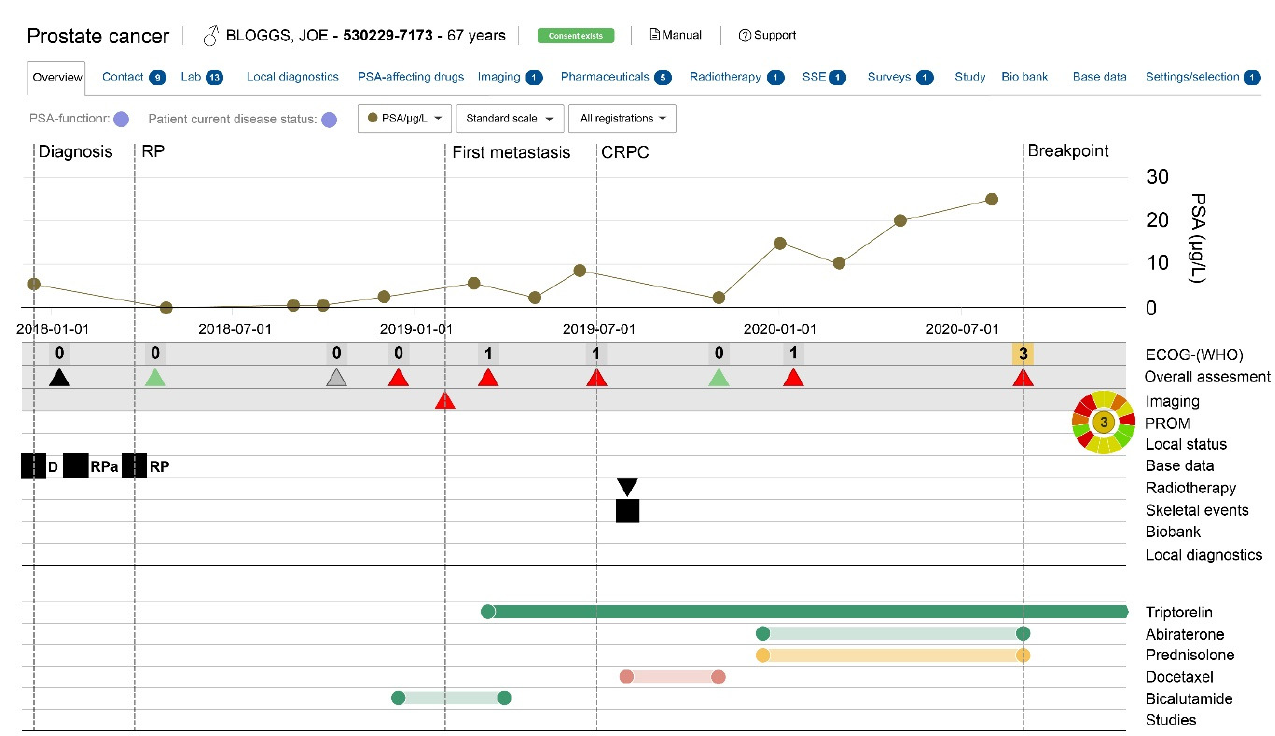
Figure 2. Example of the clinical “decision aid” generated for a fictitious patient in the Patient-overview Prostate Cancer (PPC). Legend: Red = poor performance; yellow acceptable performance/ green = good performance; Full colour shows ongoing drug, weak colour shows previous drugs use that has stopped; D = Date for diagnosis; RPa = Date of decision to perform radical prostatectomy; RP = Date radical prostatectomy performed.